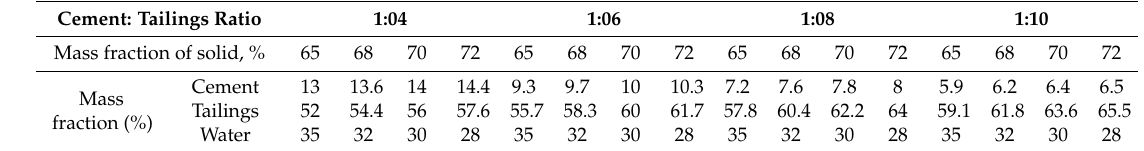
Figure 2. Some images of CTB sample preparation process.